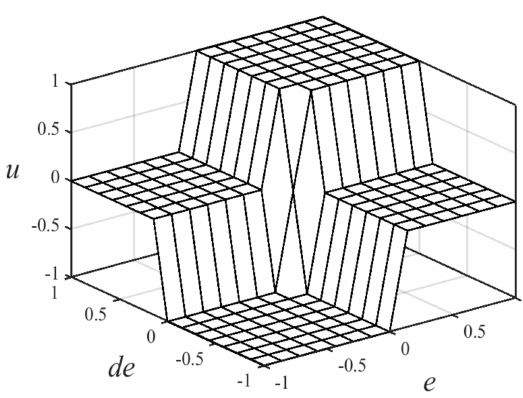
Figure 14. Fuzzy sets of the fuzzy logic controller.